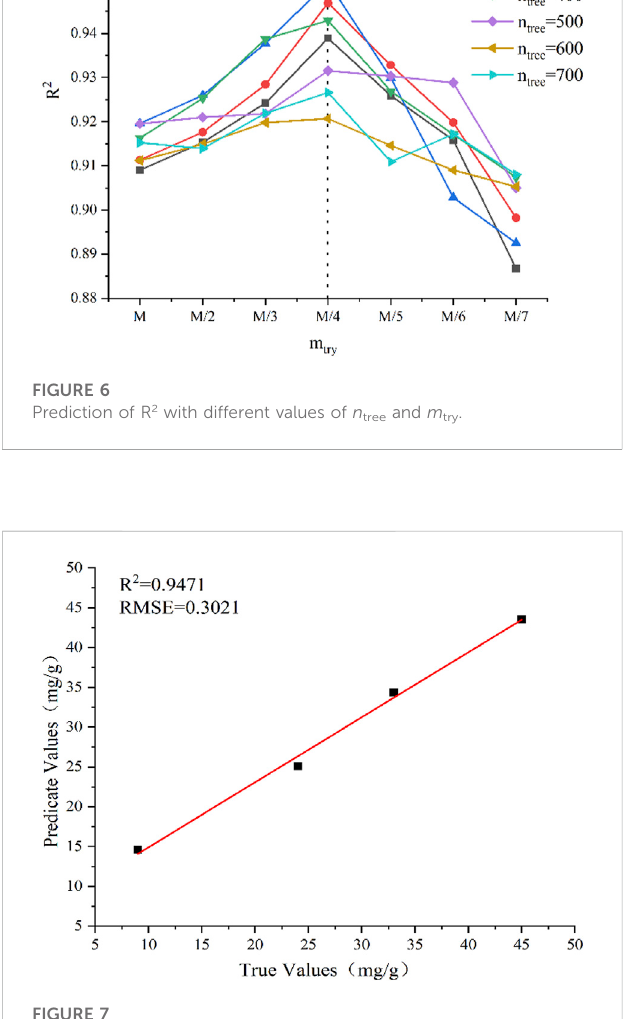
Prediction results using RF model for Fertilization.